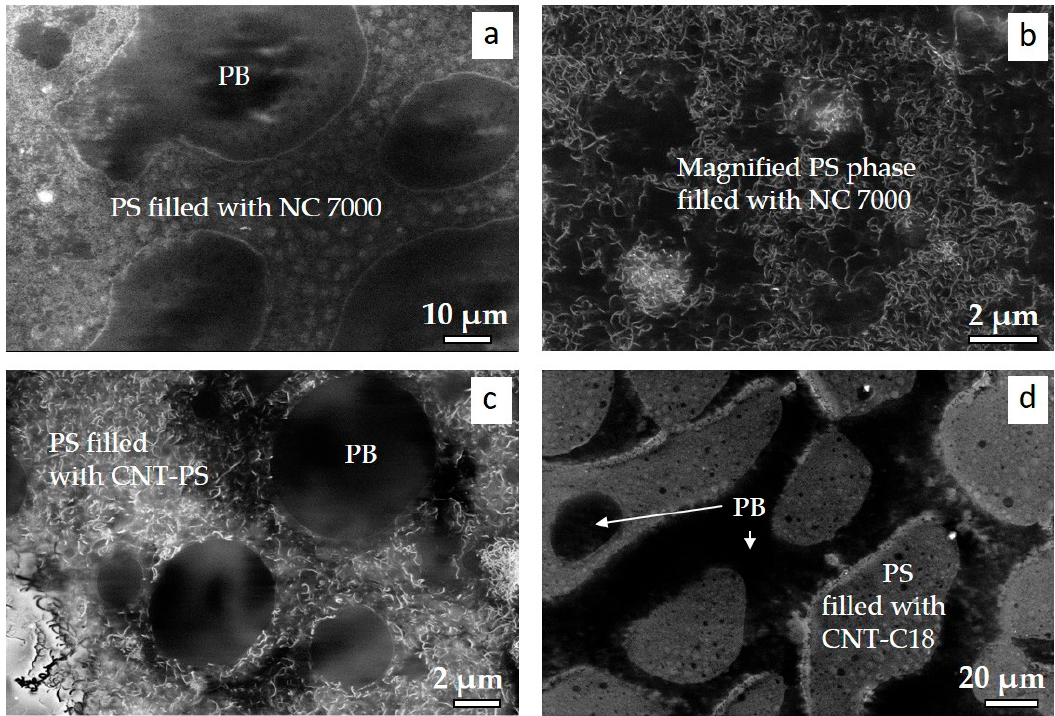
Figure 7. SEM images of PS / PB blends with 1 wt % of MWCNTs dispersed in toluene, prepared on glass substrates: ( a , b ) NC 7000, ( c ) CNT-PS, and ( d ) CNT-C18; prepared on glass substrates; using InLens detector to visualize CNTs localized in the PS phase.